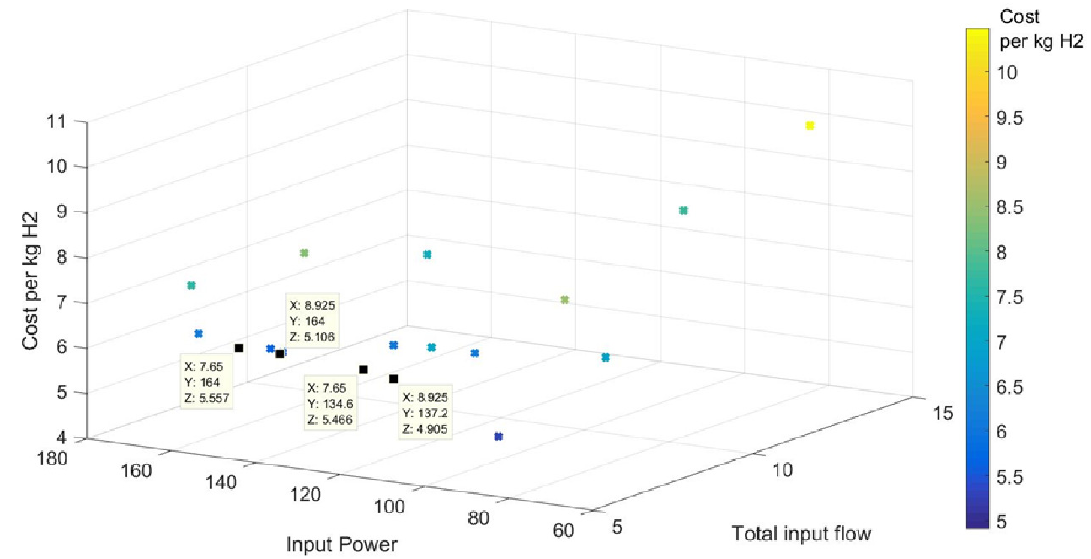
Figure 5. Change is cost of hydrogen with total flow and input